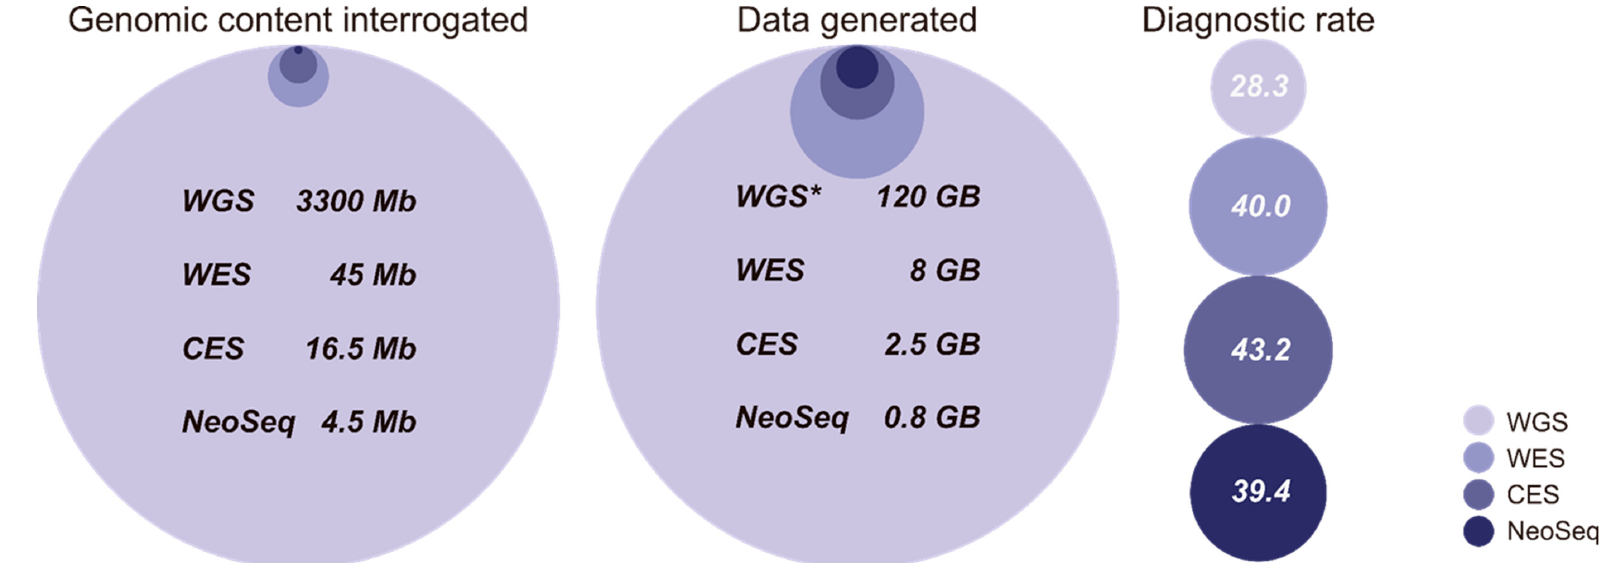
Figure 1. Schematic comparing NeoSeq and other diagnostic genome sequencing strategies (WGS 14,15,20,22 , WES 16,18,19,23, and CES 12,13,17 ) showing the size of the genomic portion interrogated, the amount of data generated, and the median diagnostic rates achieved for each approach. To facilitate visual comparison, data are represented as the relative area of each circle. For WGS and WES, information on the genomic portion interrogated and data generated data were extracted from www.illumina.com/wes-wgs. For CES, information on the genomic portion interrogated and data generated was estimated for 6000 genes. Diagnostic rates were calculated as the mean of the results of the cited studies. Total number of patients for each genome sequencing strategy: CES, n = 306; WES, n = 242; WGS, n = 395.